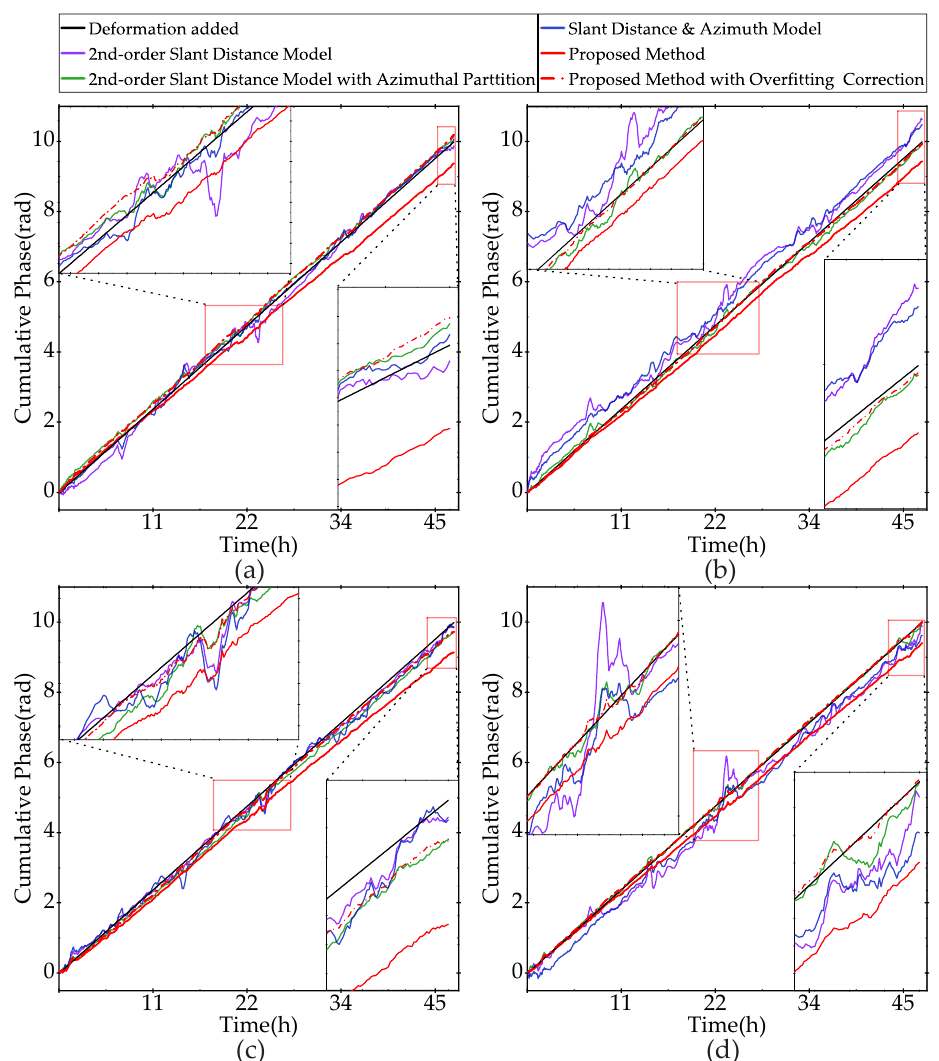
Figure 17. CP median curves of simulated deformation areas, ( a – d ) are the median curves of A–D in Figure 16,